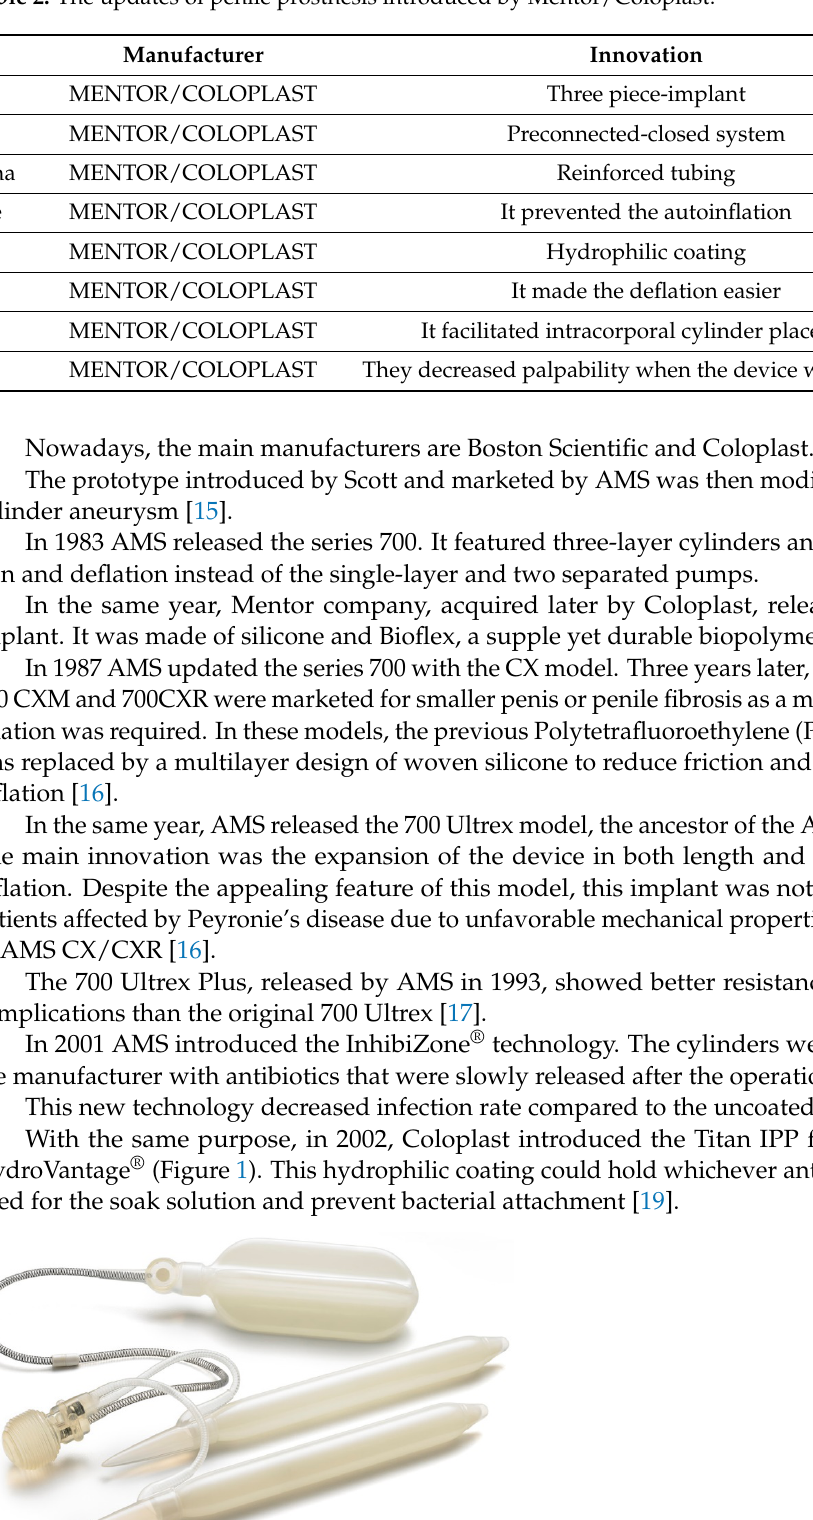
Table 2. The updates of penile prosthesis introduced by Mentor/Coloplast.